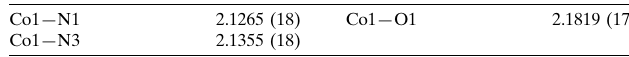
Selected geometric parameters (A˚ , (cid:2) ).